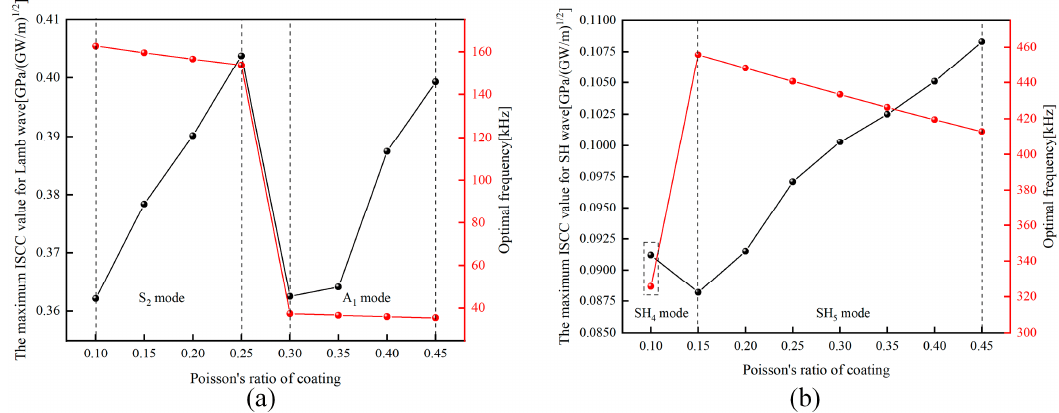
Figure 9. E ff ect of coating Poisson’s ratio on ISCC value and optimal frequency: ( a ) Lamb wave; ( b ) SH Figure 9. Effect of coating Poisson's ratio on ISCC value and optimal frequency: ( a ) Lamb wave; ( b ) SH wave.